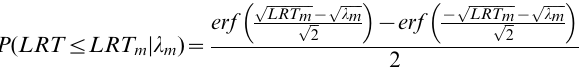
p (cid:3) (cid:4) ffiffiffiffiffiffiffiffiffiffi LRTm p { ffiffiffiffiffi l { erf { ffiffiffiffiffiffiffiffiffiffi LRTm m ffiffi 2 p